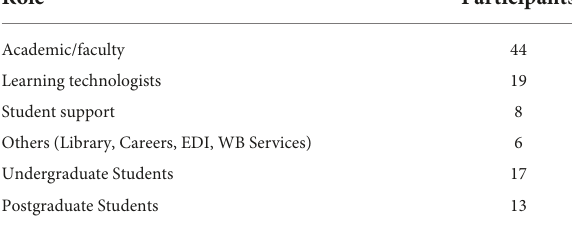
TABLE 1 University of Warwick digital repository consulted